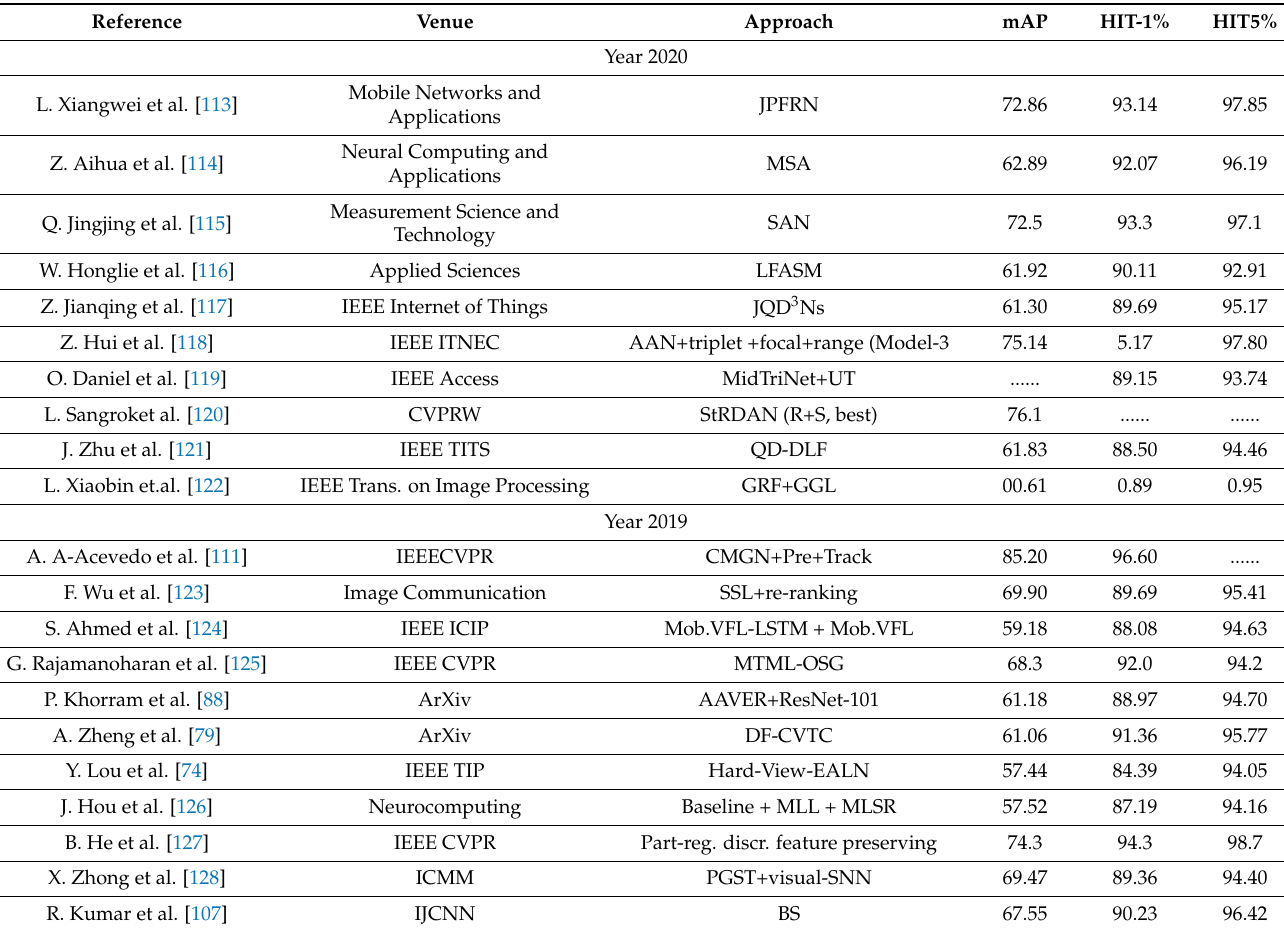
Table 4. Performance analysis of some proposed approaches in state-of-art on